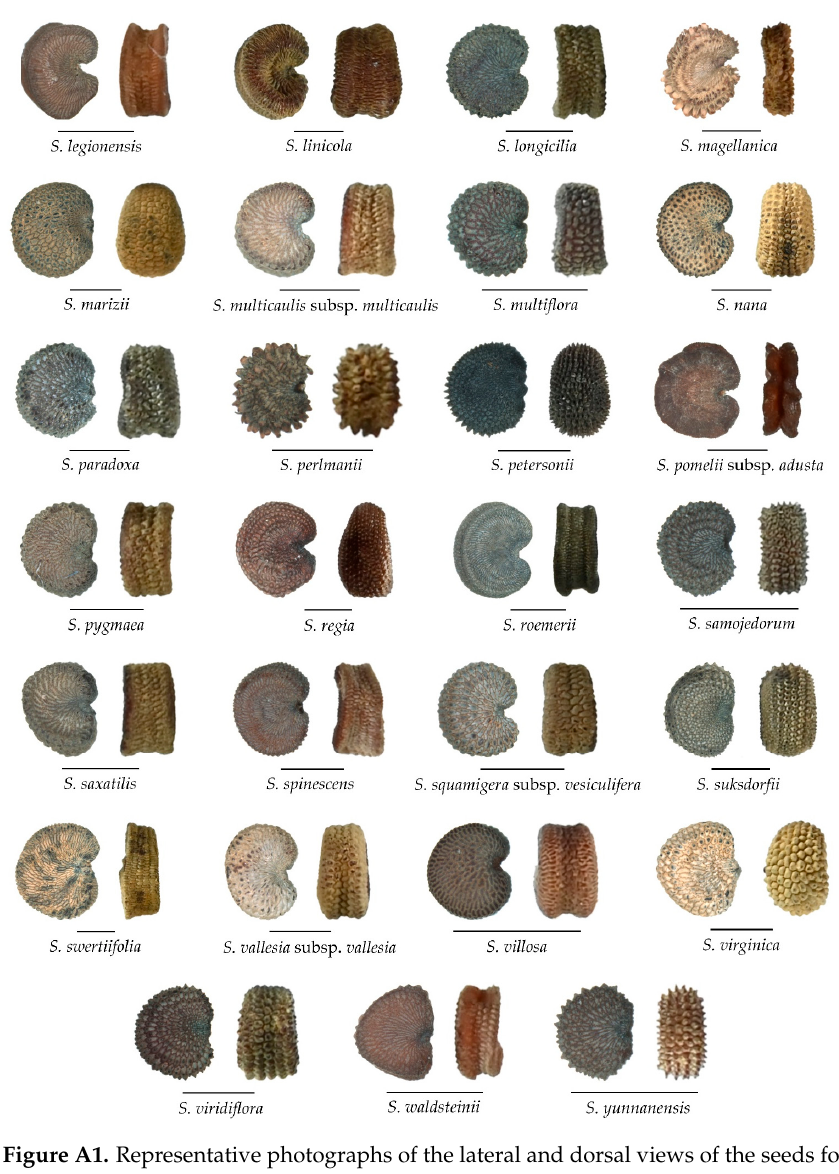
Figure A1. Representative photographs of the lateral and dorsal views of the seeds for the species of Eudianthe (A.), and Silene (S.) used in this work. Bars represent 1 mm.